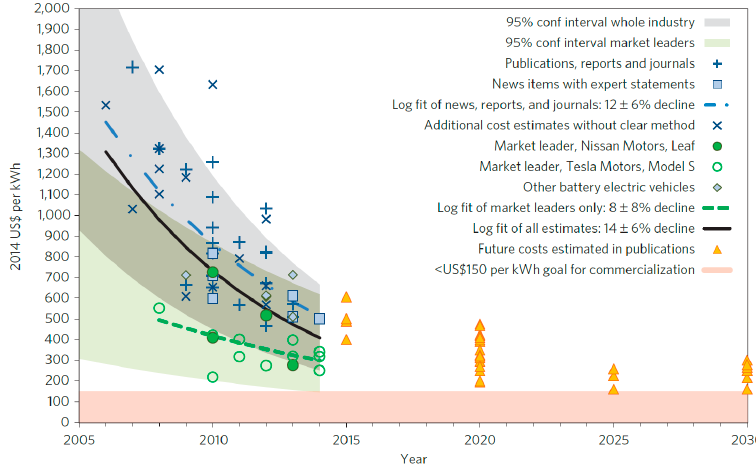
Figure 3. Cost of Li-ion battery packs in EV. Adapted with permission from [10], © Nature Publishing Group, 2015.